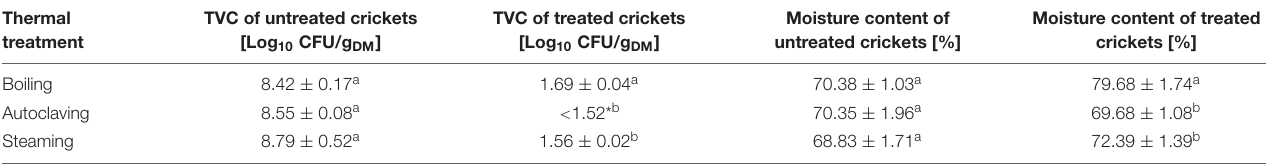
TABLE 2 | TVC and moisture content of crickets after different thermal inactivation steps.